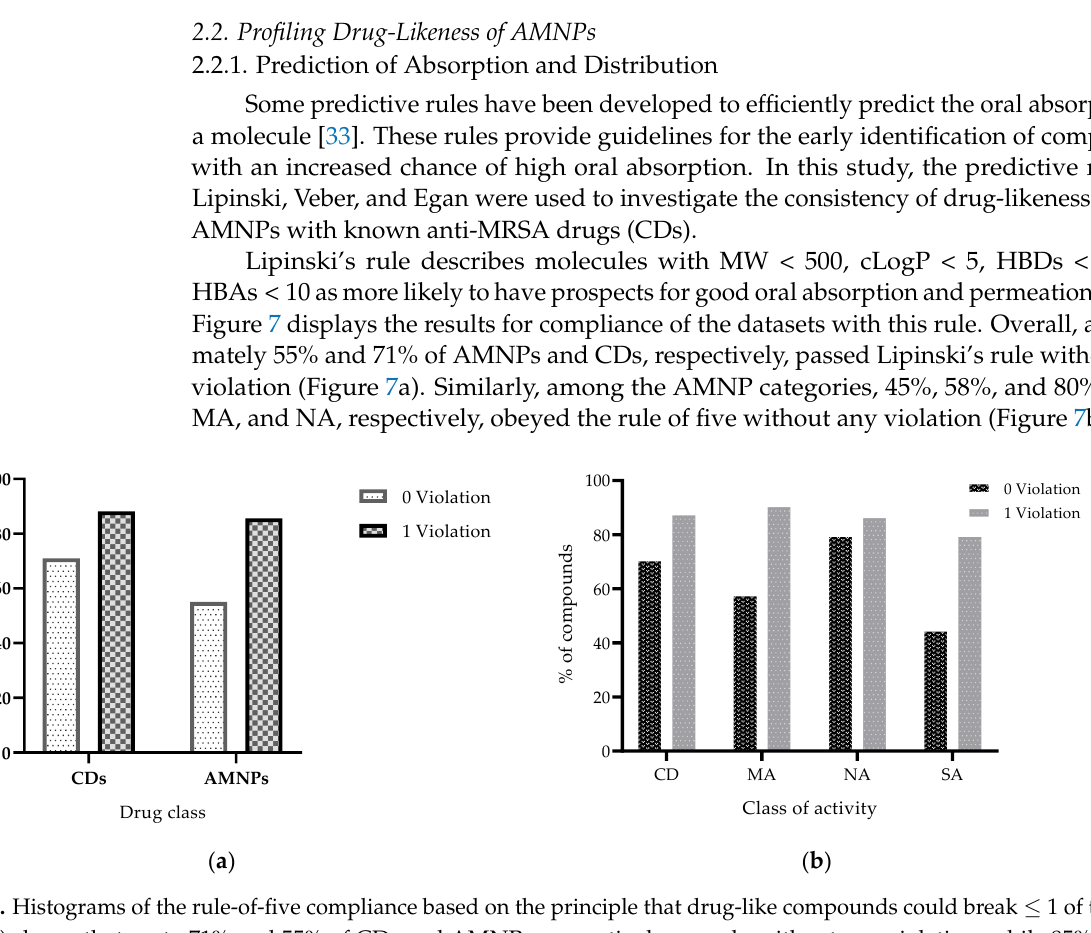
Figure 6. Distribution of rotatable bonds for the datasets. ( a ) shows the plot of RTBs for AMNPs compared with that for CDs, where both classes showed comparable distribution. ( b ) shows the distribution of the various categories of AMNPs compared with that of CDs. The boxes depict each of the datasets, while the line that divides the boxes represents the median of the distributions. The black bars in both figures indicate a 95% confidence interval.